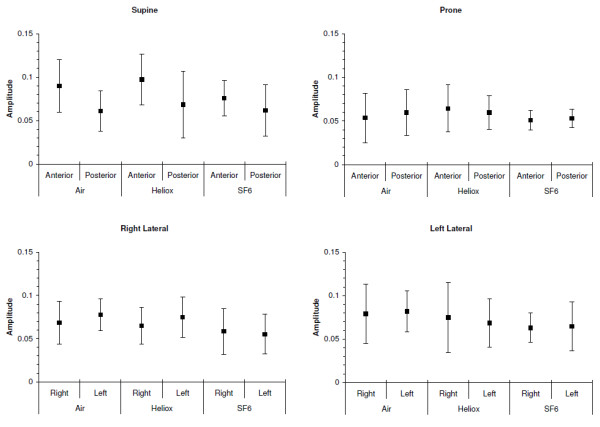
Magnitude of regional impedance amplitudes using air, heliox and sulfur-hexafluoride (SF6).